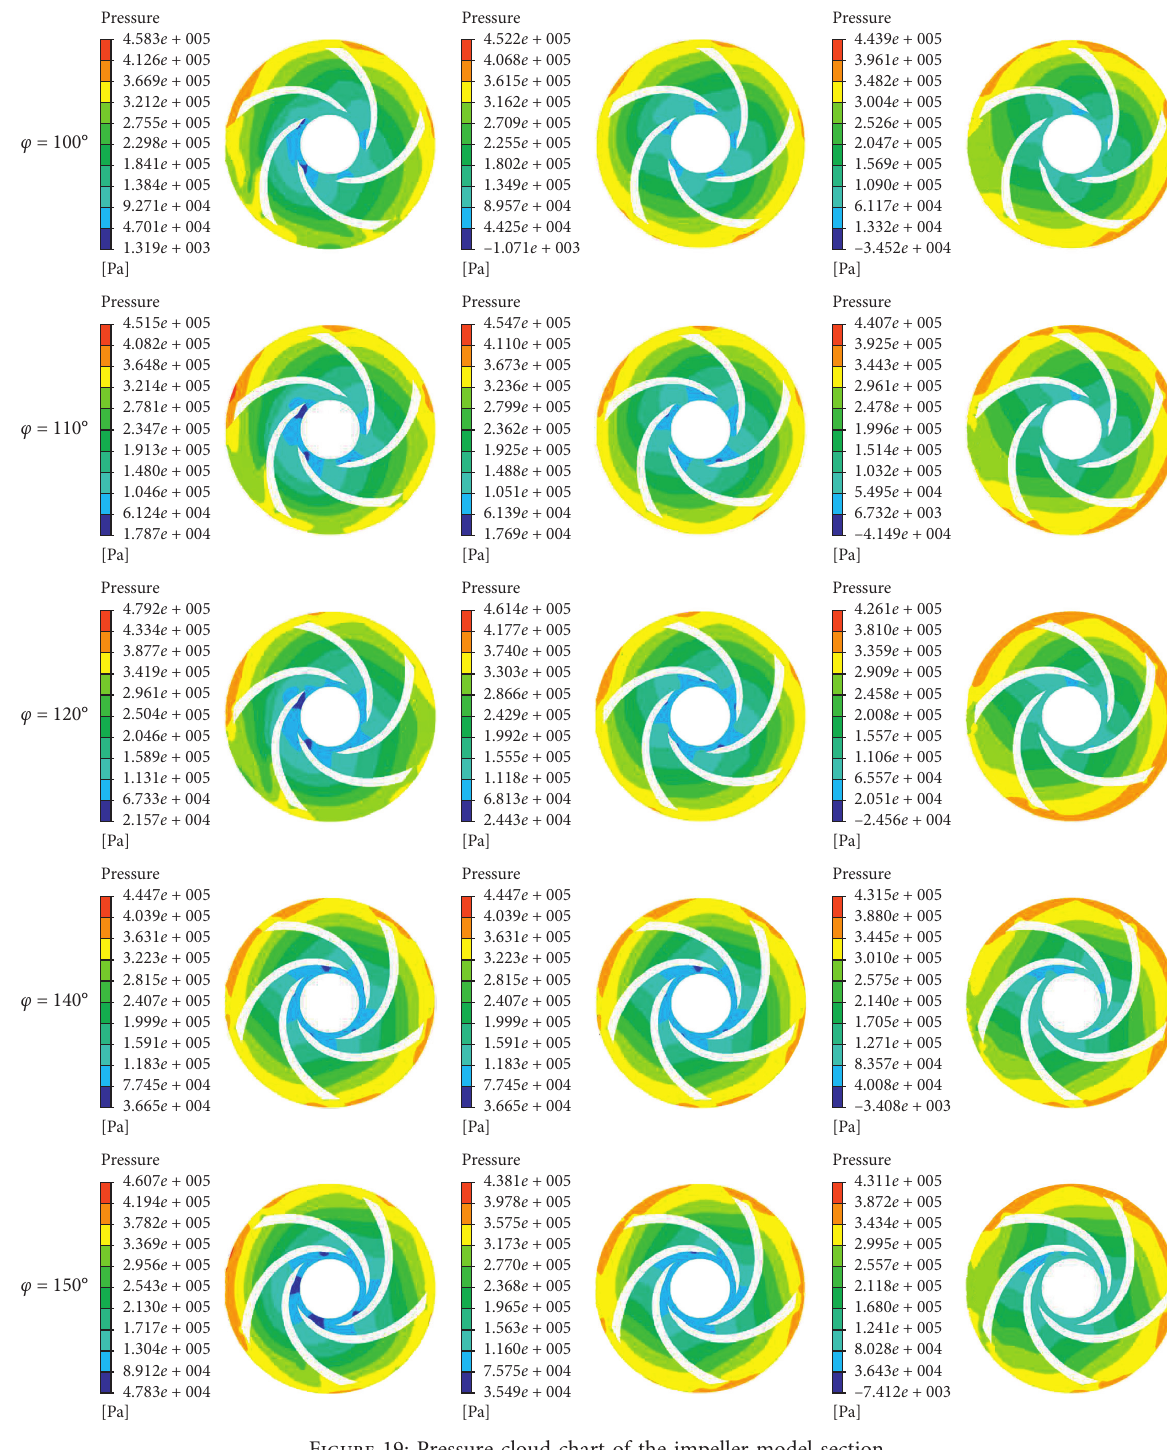
Figure 19: Pressure cloud chart of the impeller model